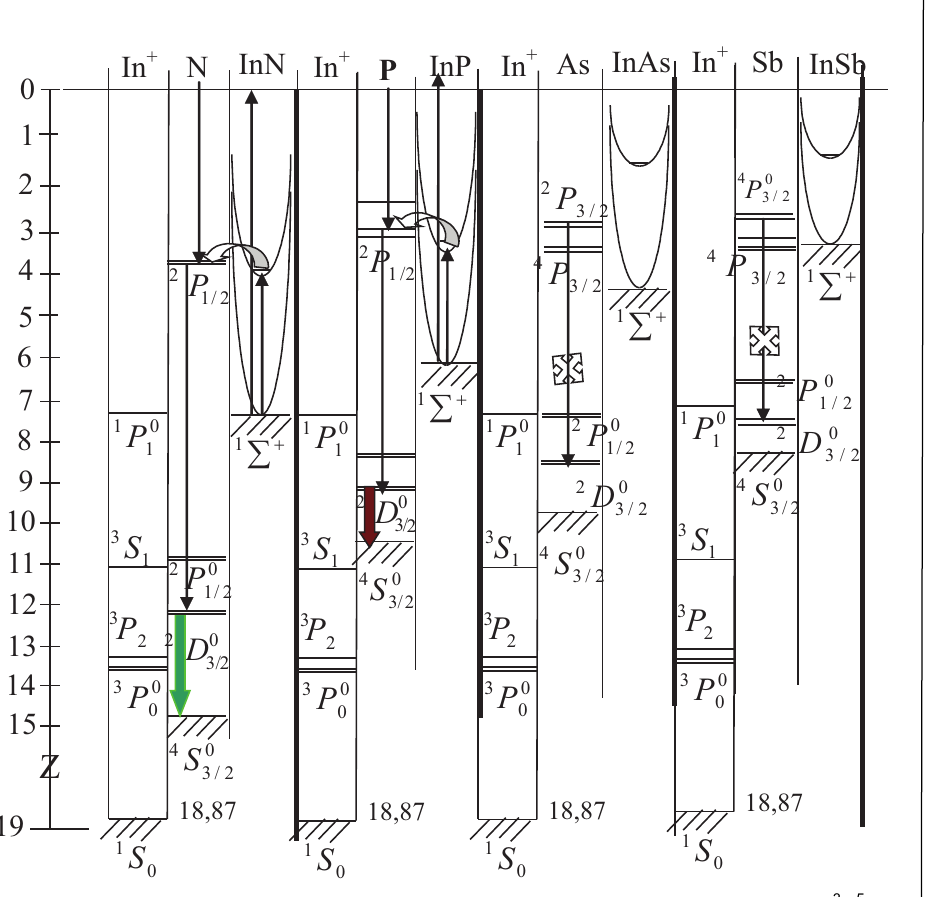
Рис . 1 – Примерная схема уровней энергий в двухатомных молекулах типа А 3 В 5 Figure 1 – Approximate schematic presentation of the energy levels in A 3 B 5 diatomic molecules Slika 1 – Približna šema energetskih nivoa u dvoatomskim molekulima tipa А 3 В